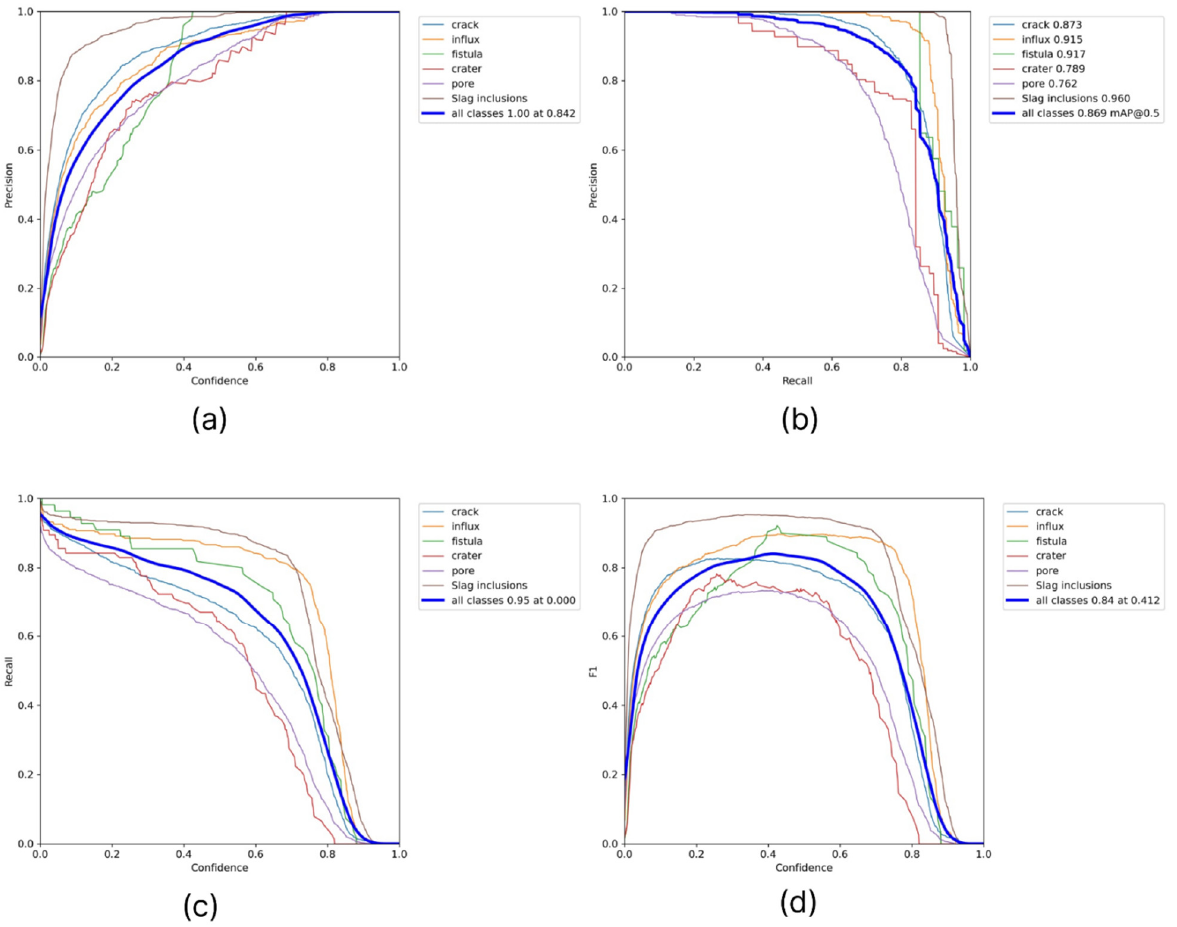
Figure 9. Mutual dependencies of the model metric indicators used ( a ) precision–confidence, ( b ) precision–recall, ( c ) recall–confidence, and ( d ) F1–confidence.